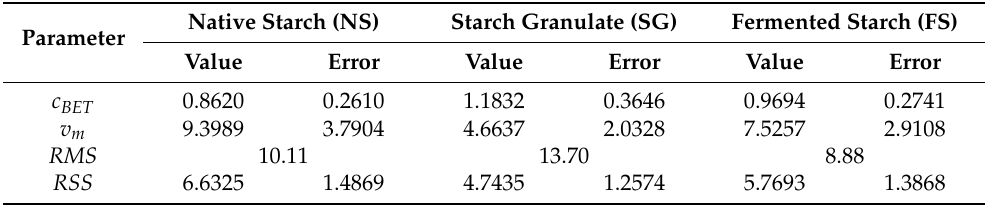
Table 3. Parameters of BET equation determined for the analyzed cassava